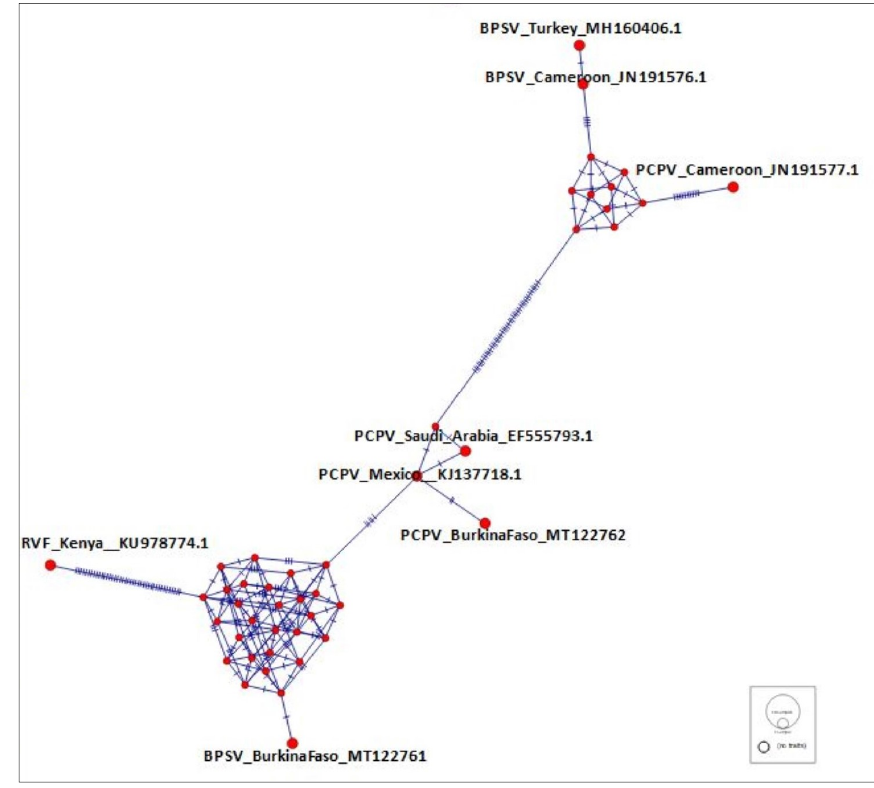
Figure 2. Neighbor-joining phylogenetic tree based on the partial sequences of the major envelope protein (B2L) gene of Bovine Papular Stomatitis and Pseudocowpox virus. Origins and accession numbers of reference sequences of BPSV (Bovine Papular Stomatitis Virus), PCPV (Pseudocowpox virus) as well as that of RVFV (Rift Valley Fever Virus) are indicated. Blue circles refer to samples from elsewhere in Africa, while red squares correspond to our samples from Burkina Faso.